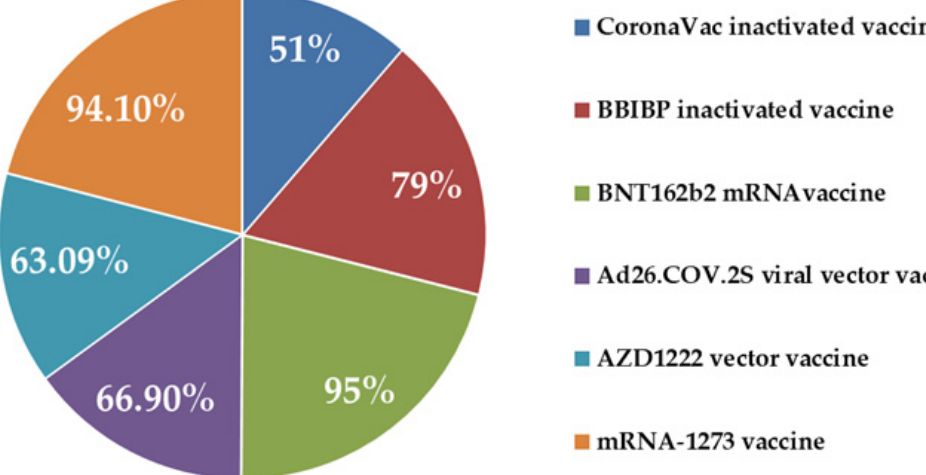
Figure 4. Percentage efficacy of WHO approved vaccines against symptomatic COVID ‐ 19.